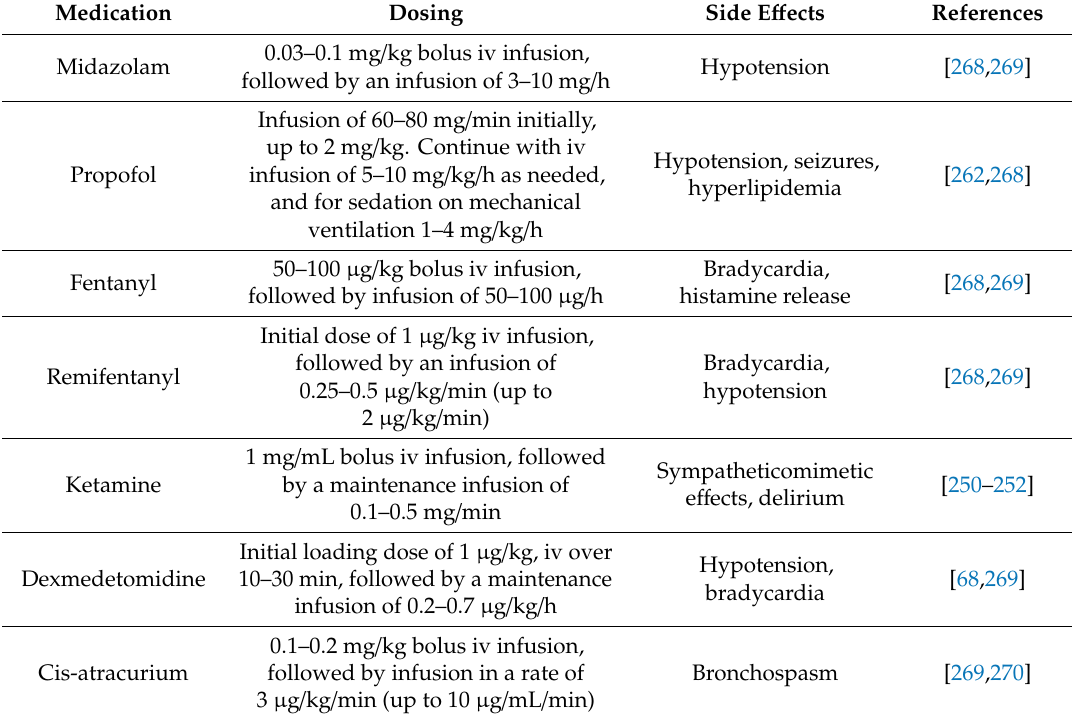
Table 3. Sedation, analgesia and paralysis in patients with acute severe asthma exacerbation requiring